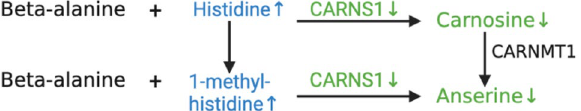
Figure 3. Reduced levels of carnosine and anserine in wooden breast affected chickens, likely due to down- regulation of carnosine synthase 1 (CARNS1). Different colors indicate higher (blue), lower (green) and not statistically different (black) abundance of a metabolite or gene transcripts in wooden breast affected p. major muscle. This figure was created with BioRender.com (http:// biore nder.